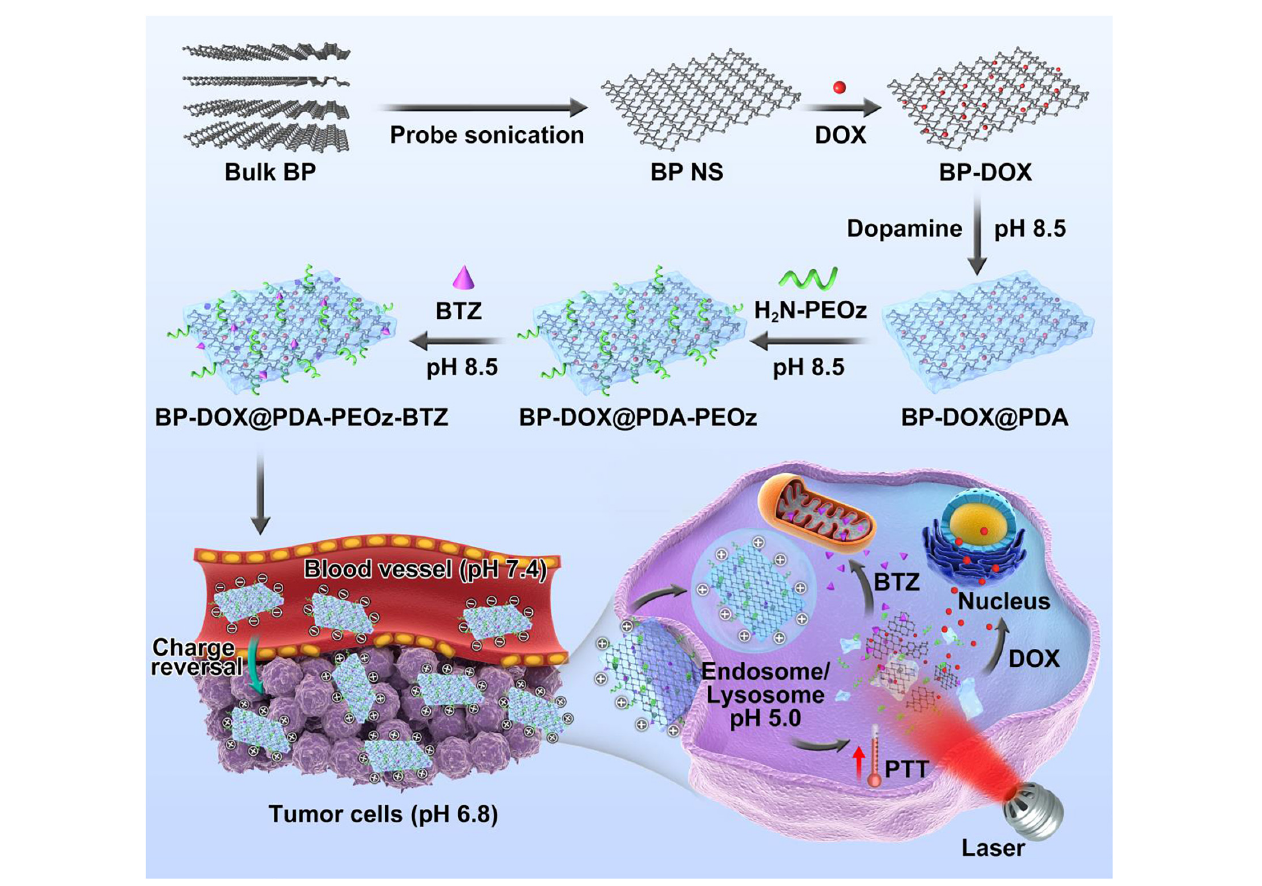
FIGURE 1 | Schematic representation of dual-drug-loaded BP-DOX@PDA-PEOz-BTZ and summary of the endocytosis pathways and chemo-photothermal synergistic therapy of cancer.